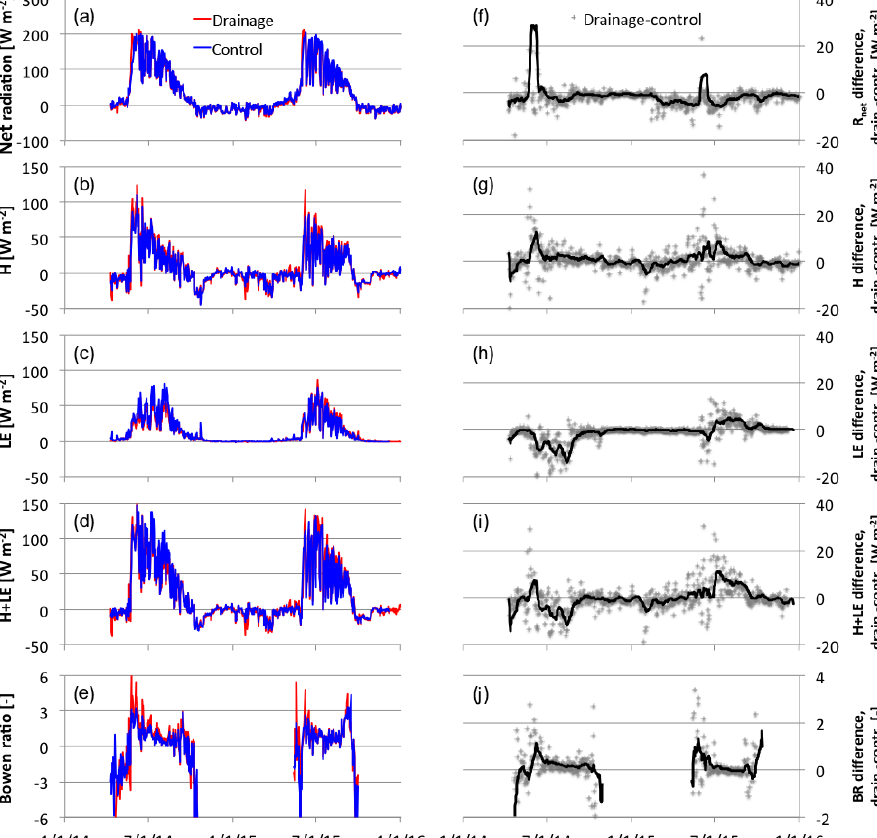
Figure 9. (a–e) Summary of daily averaged energy fluxes within drainage (red line) and control (blue line) areas. (f–j) Daily differences (drainage minus control, grey crosses) between the two treatments, with black lines giving the average differences for a 15-day moving window. (a, f) Net radiation; (b, g) sensible heat fluxes; (c, h) latent heat fluxes; (d, i) sum of sensible and latent heat fluxes; (e, j) Bowen ratio, which is the ratio of sensible to latent heat fluxes. Vertical scales of difference plots have been truncated to enhance display of fine-scale patterns in overall